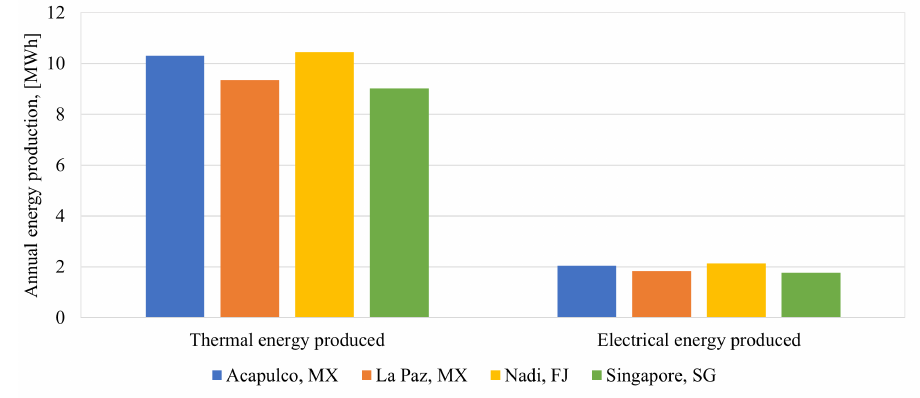
Figure 6. Annual thermal, electrical and net electrical energy production of the CPVT-VMD system under different weather